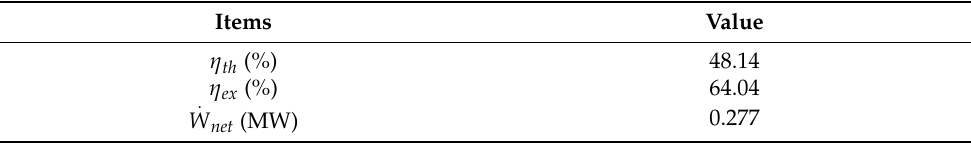
Table 4. Energy and exergy results for a basic parameters design.